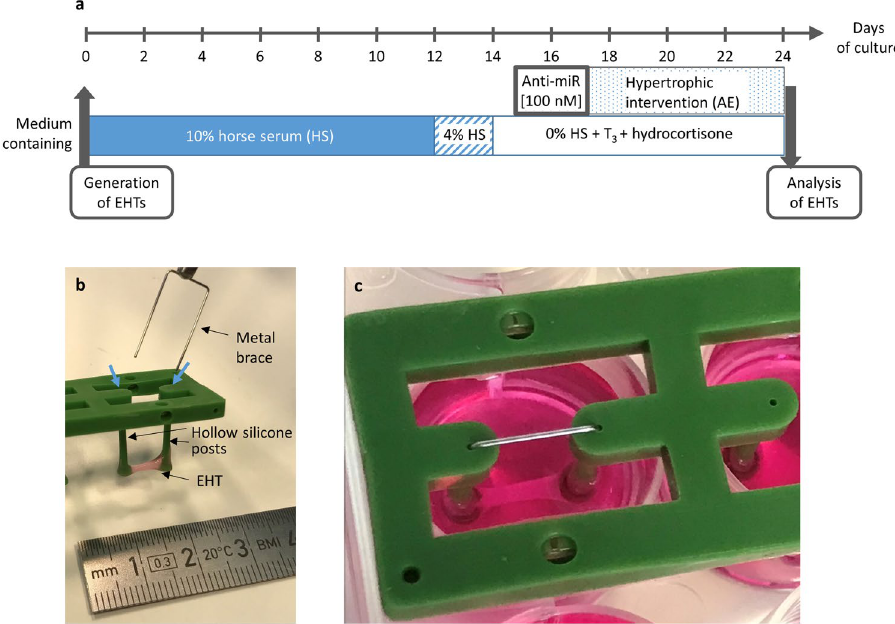
Figure 1. Engineered heart tissue (EHT) and the afterload enhancement (AE) procedure to induce hypertrophy. ( a ) Outline of the experimental procedure. ( b ) Photograph of an EHT taken out of the cell culture dish. To increase afterload of the EHTs, a metal brace is inserted into the opening of the posts (blue arrows). ( c ) An EHT in the cell culture dish during the